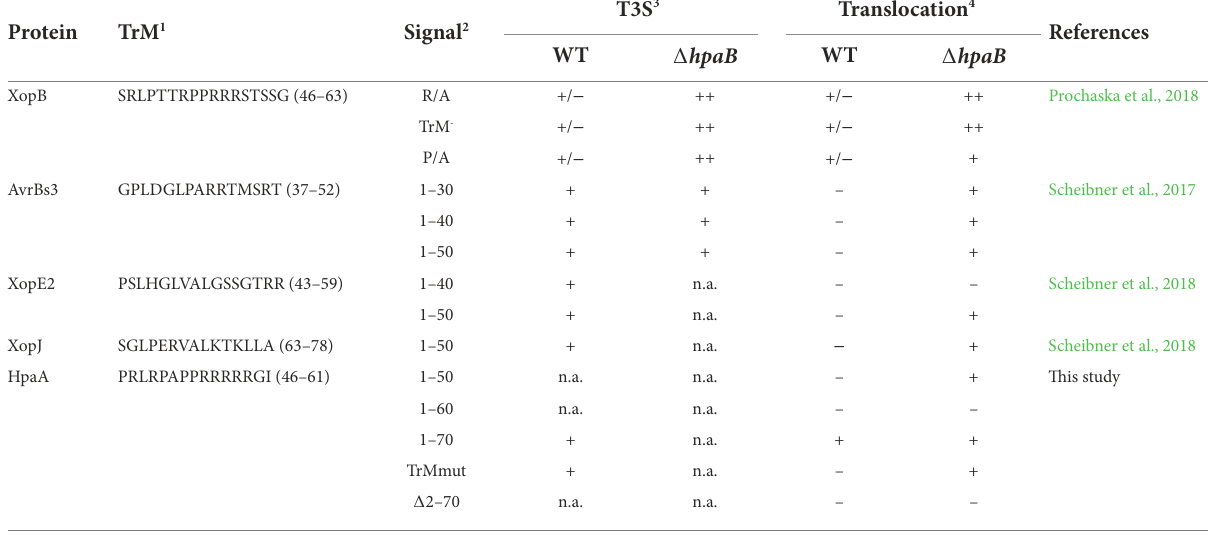
TABLE 1 Contribution of TrM sequences in T3Es from X. euvesicatoria to T3S and translocation.